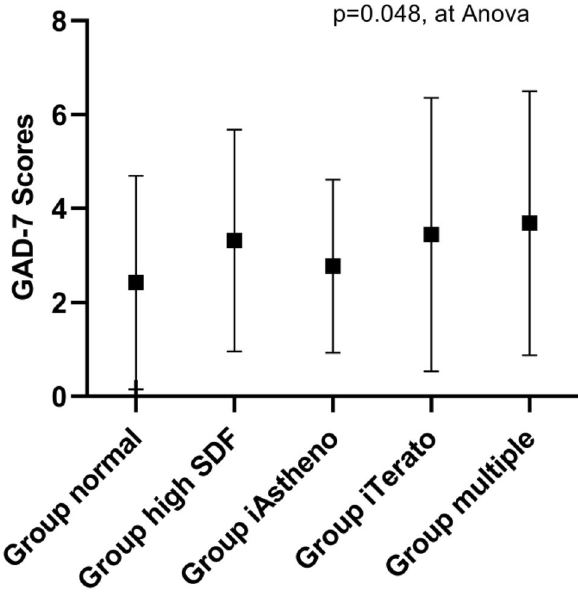
Figure 4. Graphs of the difference in GAD-7 scores according to